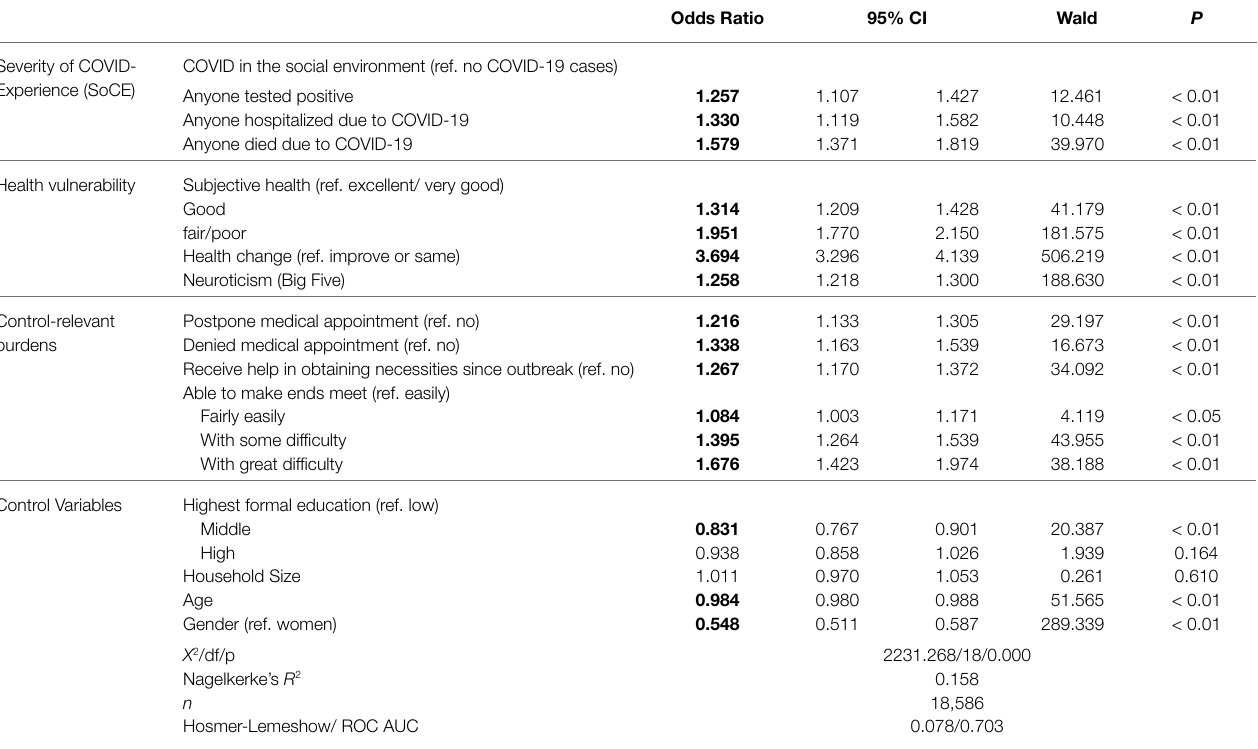
Odds Ratio 95% CI Wald